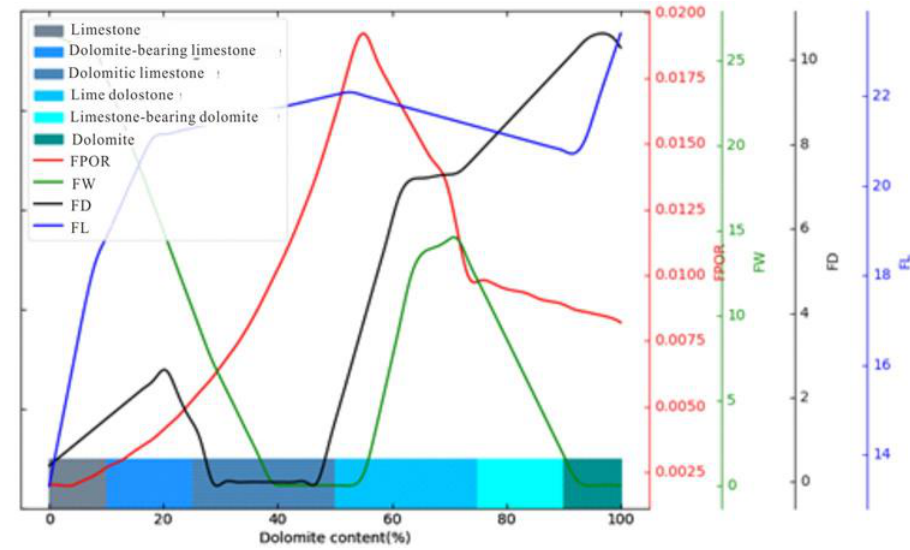
Figure 11. Development of fracture parameters with different dolomite contents under the condition of relatively high argillaceous content.